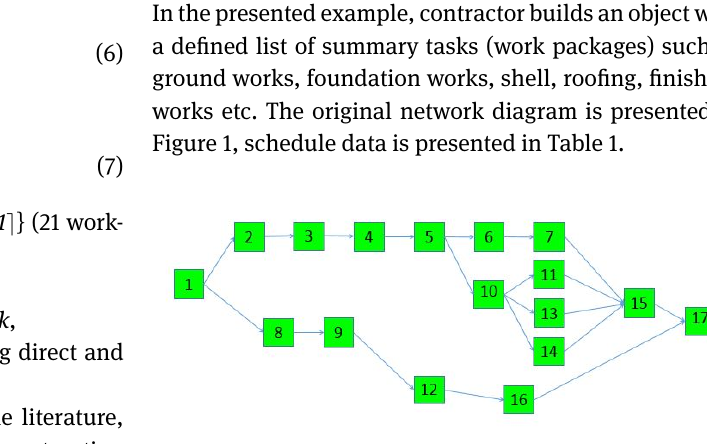
Figure 1: Network diagram of the example construction